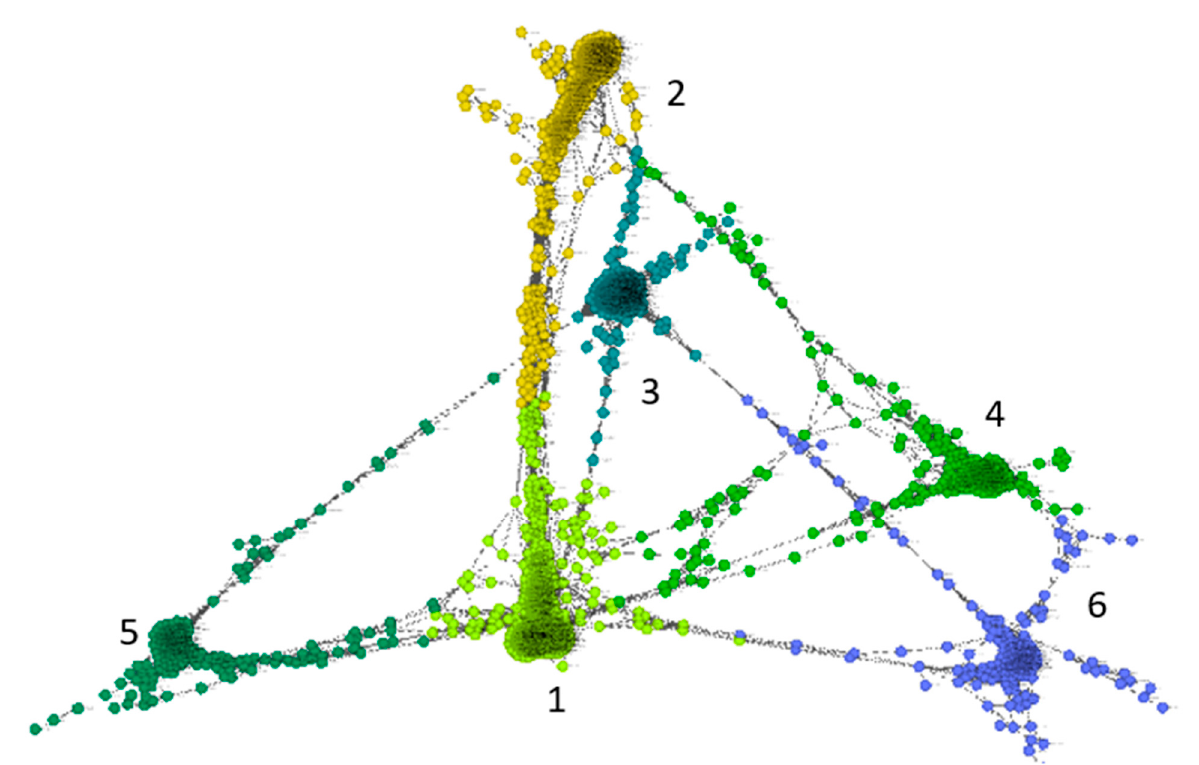
Figure 2. Correlation network clustering of operation taxonomic units (zOTUs) present in fish and plant compartments of an aquaponics system. Figure generated using Graphia software (r ≥ 0.95) and OUT data from V4 16S rRNA. Fish compartment zOTUs were best represented by clusters 1, 3, and 5, whereas plant compartment zOTUs were best represented by clusters 2, 4, and 6.